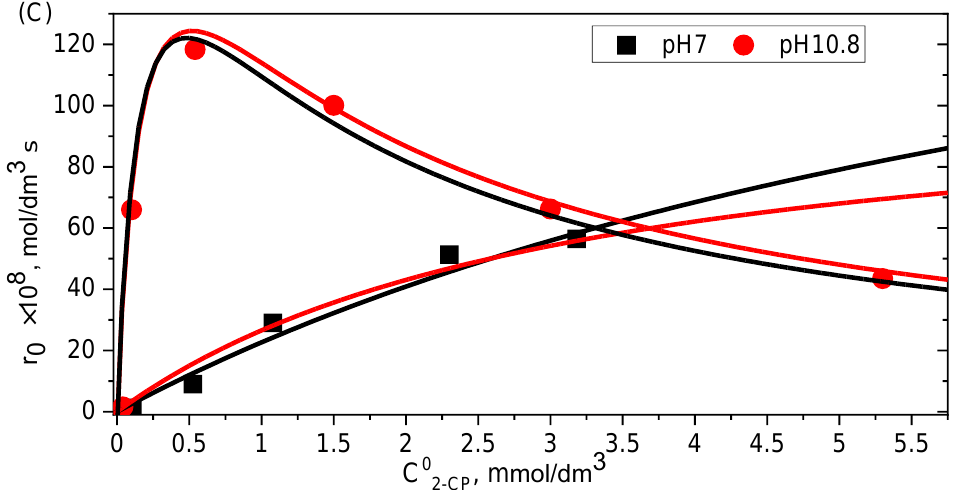
Figure 5. Dependence of reaction rate on initial BuP ( A ), BeP ( B ), and 2-CP ( C ) concentration simu- lated according to Equation (26) and Equation (27) for determining rate constants under aerated solution (0.28 mM O 2 ) at the neutral and alkaline solution. Points represent experimentally deter- mined initial reaction rates (corrected due to direct photolysis). ( ▬ Equation (26), method 1; ▬ Equation (26), method 2; ▪▪▪▪ Equation (27), method 1; ▪▪▪▪ Equation (27), method 2), E 0 = 3.24 × 10 − 4 einstein s − 1 dm − 3 . Table 3. Determined kinetic rate constant of BuP reaction with singlet oxygen and excited 3 TPPS 4 * with the application of Equation (26) and Equation (27) with two approaches.